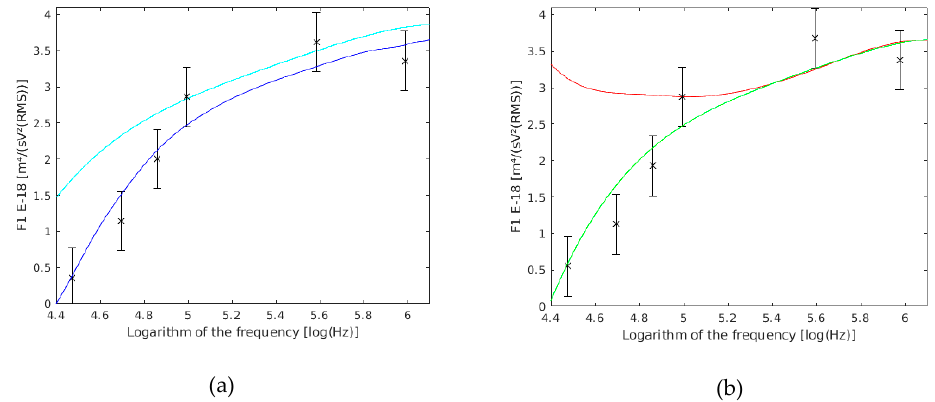
Figure 10. ( a ) F 1 variation with the cell membrane relative permittivity ( ε m ). F 1 with 10.4 cell membrane relative permittivity are shown in cyan, those with a 5.2 cell membrane relative permittivity are shown in blue, and the results of this work are the six frequency points with their confidence intervals drawn. ( b ) F 1 variation with the cell membrane conductivity ( σ m ). F 1 with 0.001 mS / m cell membrane conductivity are shown in red, those with 0.01 mS / m cell wall conductivity are shown in green, and the results of this work are the six frequency points with their confidence interval drawn.